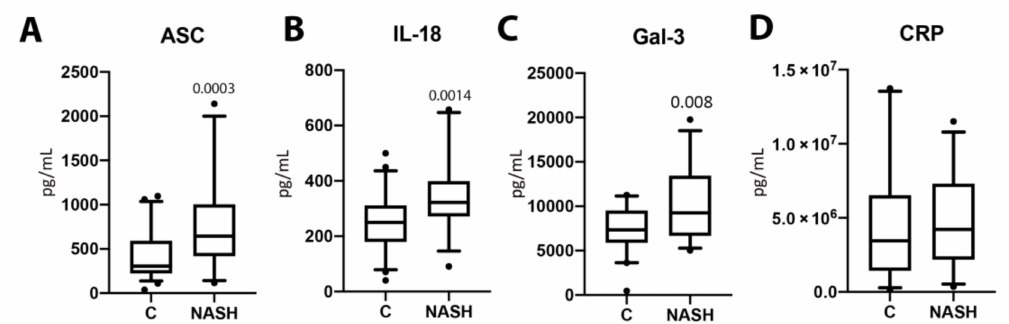
Figure 1. The concentration of inflammasome proteins is increased in NASH patient serum. The protein concentration levels in pg / mL of ASC ( A ), IL-18 ( B ), Gal-3 ( C ), and CRP ( D ) in the serum of aged-matched controls and NASH patients. N = ASC: 53 controls, 32 NASH; IL-18: 58 controls, 31 NASH; Gal-3: 39 controls, 32 NASH; and CRP: 33 controls, 31 NASH. Box and whiskers are shown for the 5th and 95th percentile. C: Control; NASH: Non-alcoholic Steatohepatitis; ASC: Apoptosis-Associated Speck-like Protein Containing a Caspase Recruitment Domain; IL-18: Interleukin-18; Gal-3: Galectin-3; CRP: C-Reactive Protein.